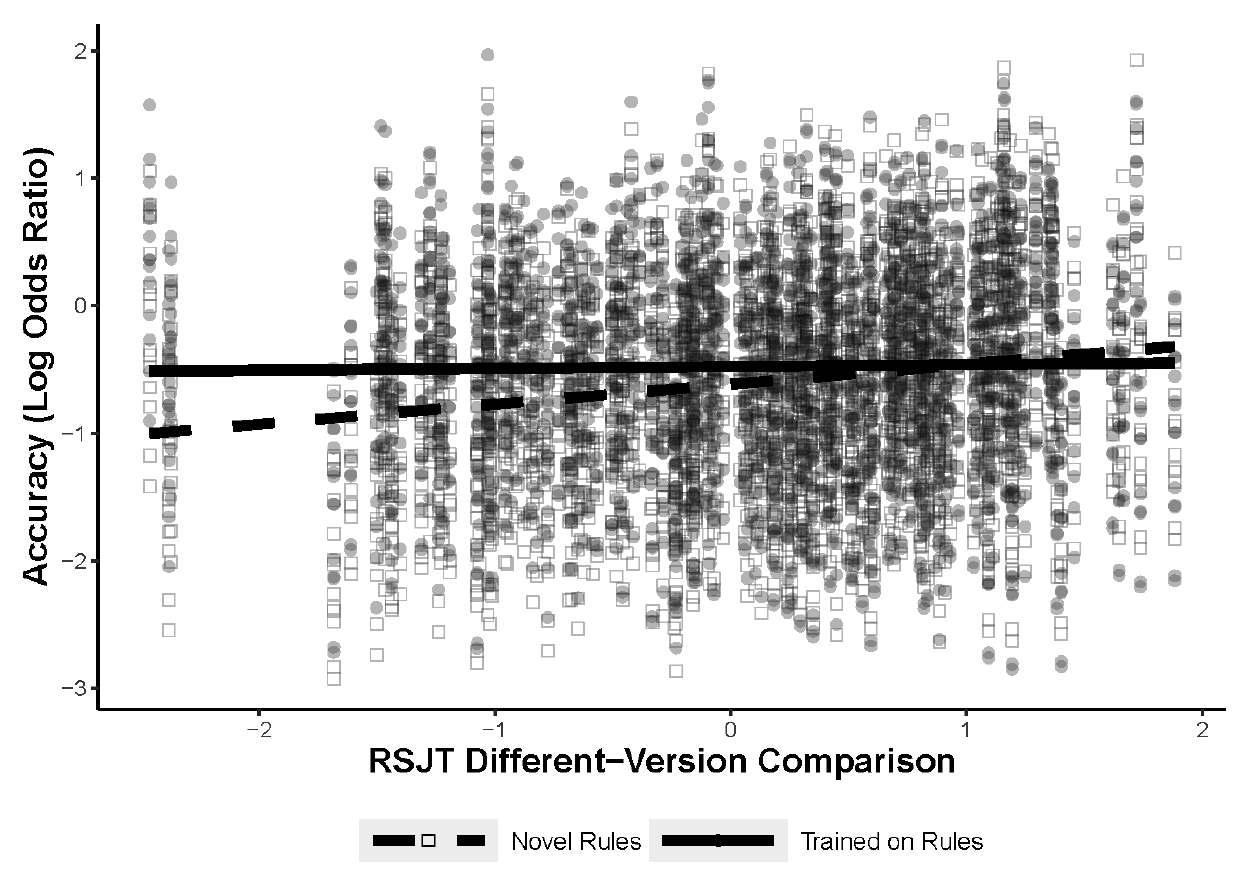
Figure 6. Interaction between RSJT different-version scores and training. Note. The plot was generated using the predict function in R to generate log odds ratio accuracy data based upon Model 1 (Table 3). The data points represent item level data for all participants and the linear slopes were generated with the geom_smooth function in ggplot. The circles represent trained-rule items and the squares represent novel-rule items.